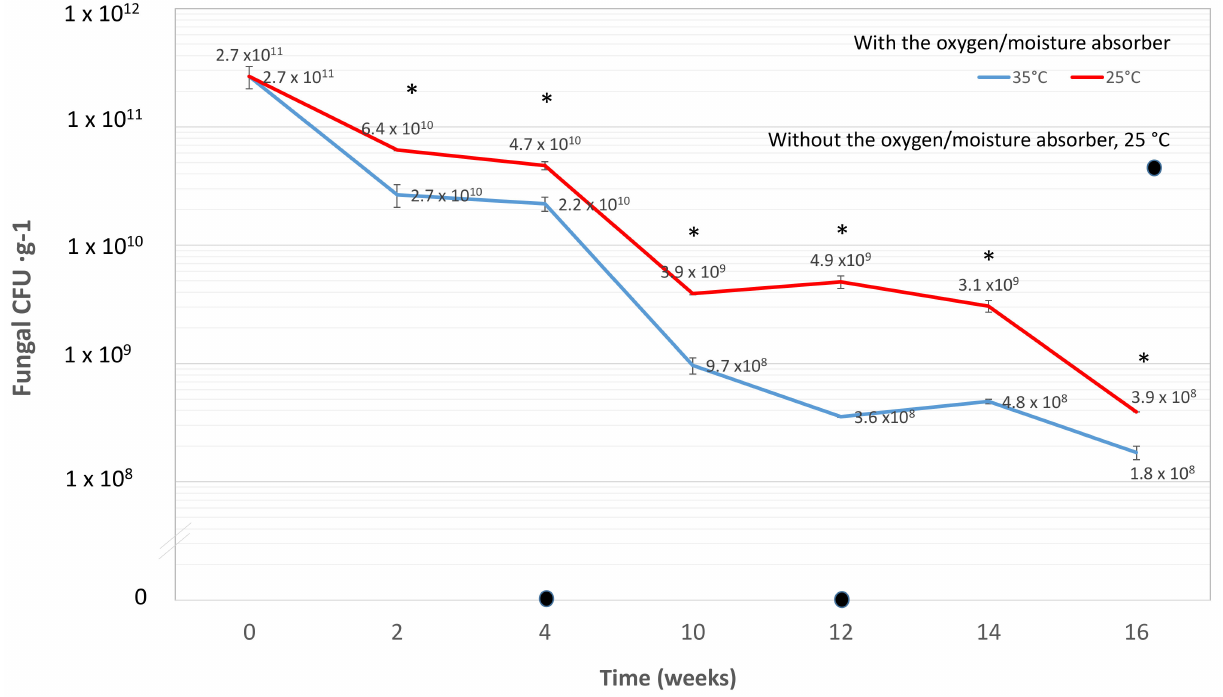
Figure 7. Shelf-life of Metarhizium sp. BCC 4849 conidia at two different temperatures of 25 and 35 ◦ C for 16 weeks. Two treatments include the conidia stored with and without the moisture/O 2 absorber sachet. Data shown are mean ± s.e.m. Asterisks indicate statistical significance between the two treatments (Student’s t -test: * p <